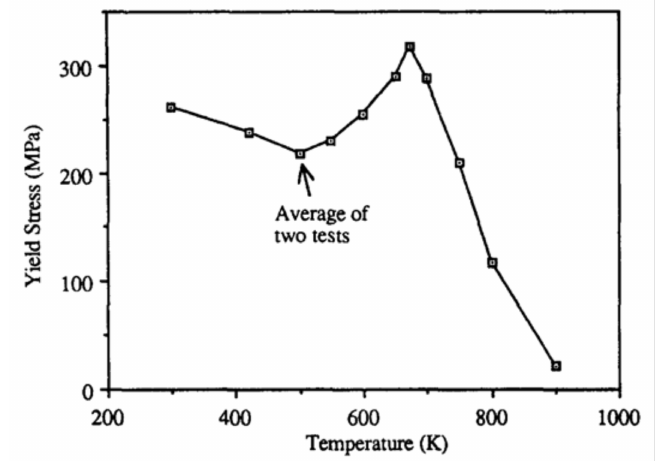
Figure 20. Variation of yield strength with temperature for Fe-40Al alloy, determined under a strain rate of 1 × 10 − 4 s − 1 . Reprinted with permission from ref. [31]. Copyright 1993 Elsevier. Klein and Baker [32] tensile-tested the annealed Fe-45Al alloy samples undoped and doped with 500 ppm boron under a strain rate of 1 × 10 − 4 s − 1 in order to study the variation in yield strength with temperature. Their results indicate that the yield strength changes with tensile temperature for both types of samples, and has a maximum value at 675 K and 800 K, respectively. Kumar et al. [12] verified experimentally that the Fe-40Al-0.6C alloy could exhibit a maximum yield strength at 600 ◦ C when testing with a strain rate of 4.7 × 10 − 4 s − 1 at different temperatures (see Figure 21).